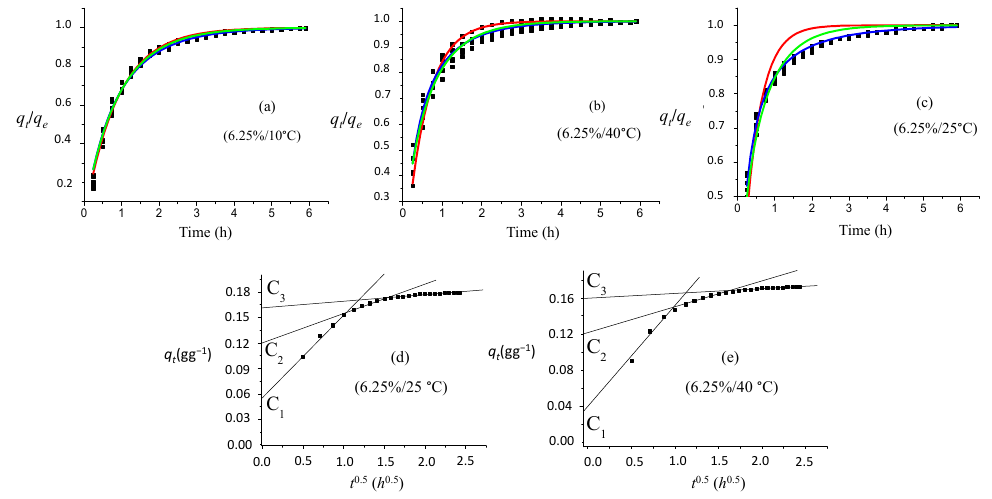
Figure 13. ( a , b , c ) Experimental and fitted kinetics data at three different temperatures (ammonia concentration 6.25%); ( d , e ) q t vs. √t at two different temperatures (6.25% of ammonia concentration), C 1 , C 2 and C 3 are the boundary layer thickness (g/g), respectively, the larger the greater the effect.